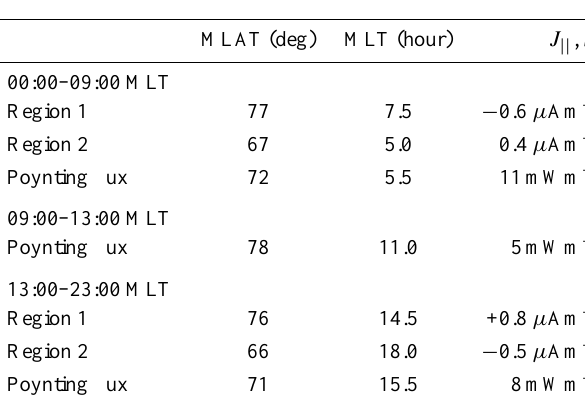
Table 1. Locations of the maximum and minimum FACs and the maximum downward Poynting flux for the three regions of en- hanced Poynting flux for 16:00–17:00 UT, 11 March 2000 (cf. Fig. 2c).